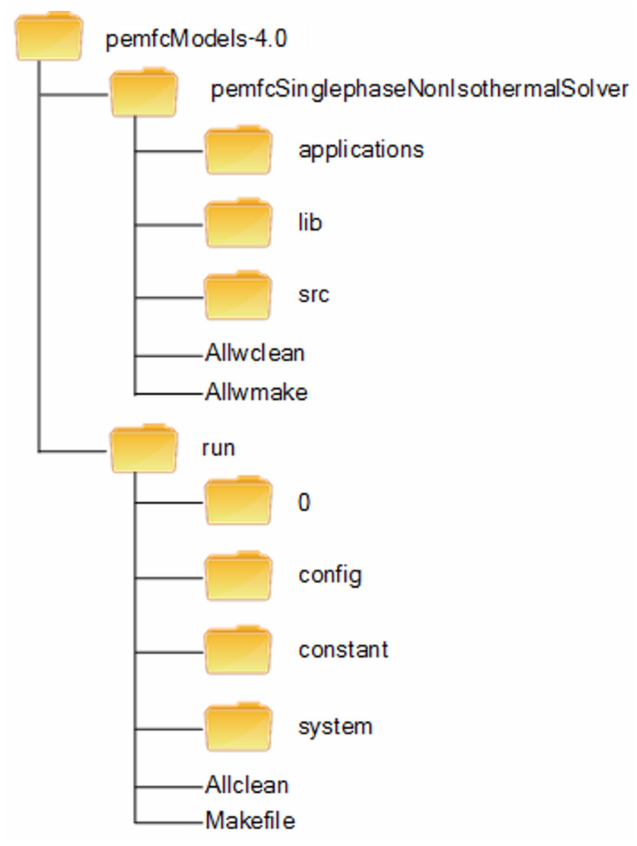
Figure 4. File structure of the